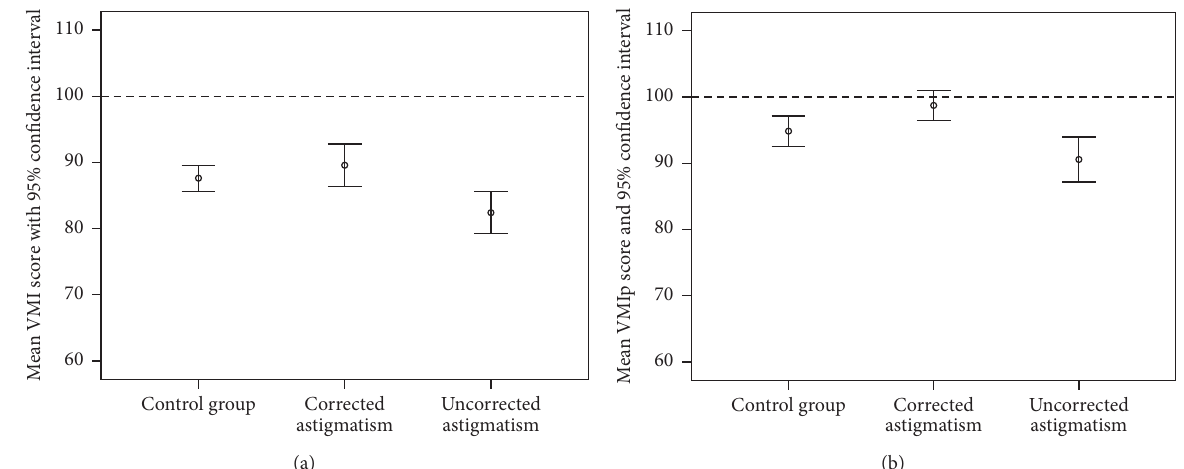
Figure 1: Mean VMI (a) and VMIp (b) standardized scores for students with low refractive error (control group) tested without correction, bilateral astigmats tested with correction, and bilateral astigmats tested without correction. Error bars represent the 95% confidence interval for the mean. Dashed line represents the average score for standardized norms